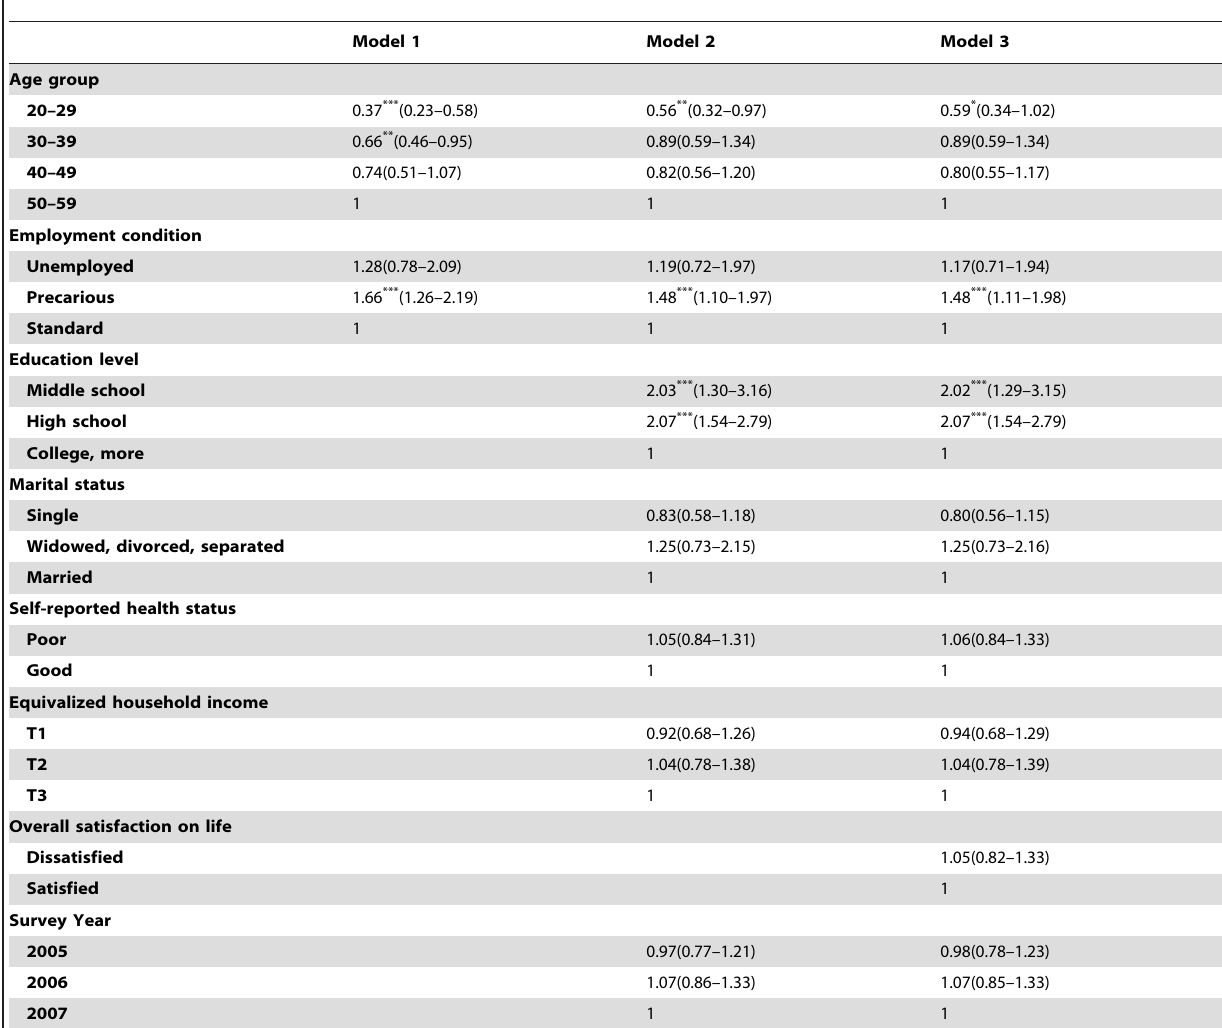
Table 3. Adjusted odds ratios(95% confidence interval) of heavy smoking according to employment